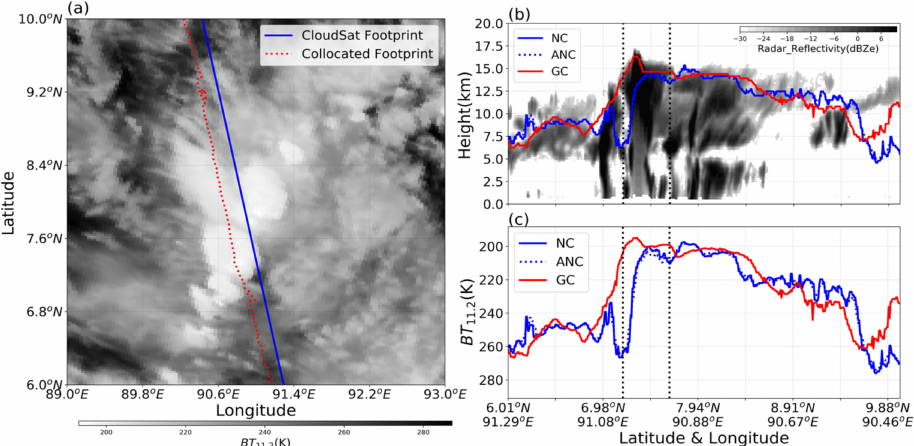
Figure 2. ( a ) HMW8/AHI 11.2 um brightness temperature (BT 11.2 ) observed at 7:40 UTC on 28 February 2017 centering at 91 ◦ E, 8 ◦ N. The blue line is the CloudSat ground track and the red dotted line is the location after geometrical correction. ( b ) The corresponding CloudSat CPR reflectivity with cloud mask value > 30. ( c ) HMW8/AHI BT 11.2 along nearest pixels of CloudSat footprint (blue line, NC), 3 × 3 pixels averaging centered at the nearest pixel of CloudSat footprint (blue dotted line, ANC), and footprint after geometrical correction (red line, GC), CTHs based on the traditional method from BT 11.2 of three methods are shown in panel ( b ). The region between the two vertical bold dotted lines indicates cloud penetrating tropopause.